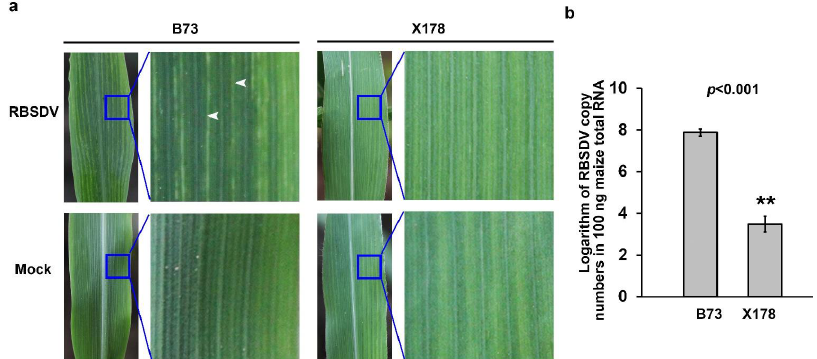
Figure 1. Infections on maize lines B73 and X178 leaves by rice black-streaked dwarf virus (RBSDV). ( a ) Enations formation on RBSDV-infected B73 leaves, but not on Mock or RBSDV-infected X178 leaves at 15 days post inoculation (dpi). White arrows indicate the enations in leaf blade abaxially along veins. ( b ) Reverse transcription-coupled quantitative polymerase chain reaction (RT-qPCR) results showed that RBSDV accumulation in the susceptible maize line B73 was significantly higher than that in the resistant maize line X178. Three independent experiments were conducted with three biological replicates per treatment in each experiment. Error bars represented the means ± SE. Significance of differences was determined using Student’s t -test. The asterisks indicate a statistically significant difference.